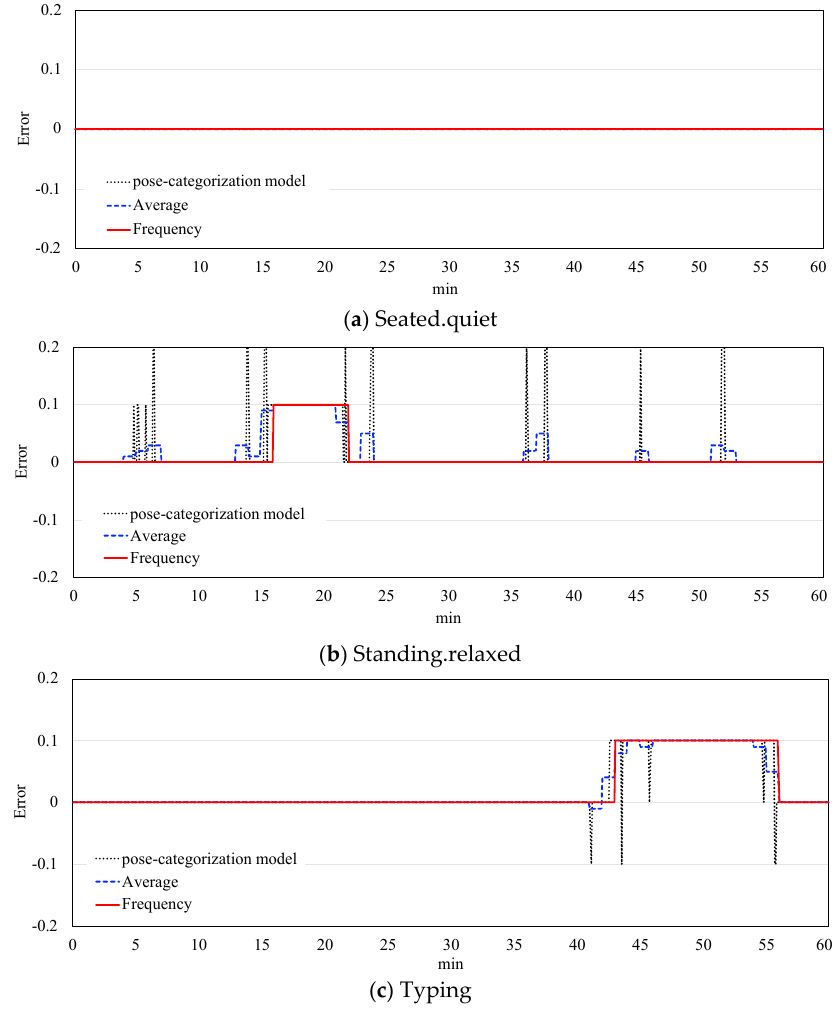
Figure 10. Errors of the two methods and the model in the case of office activities. Table 4. Accuracy of the representative metabolic rate